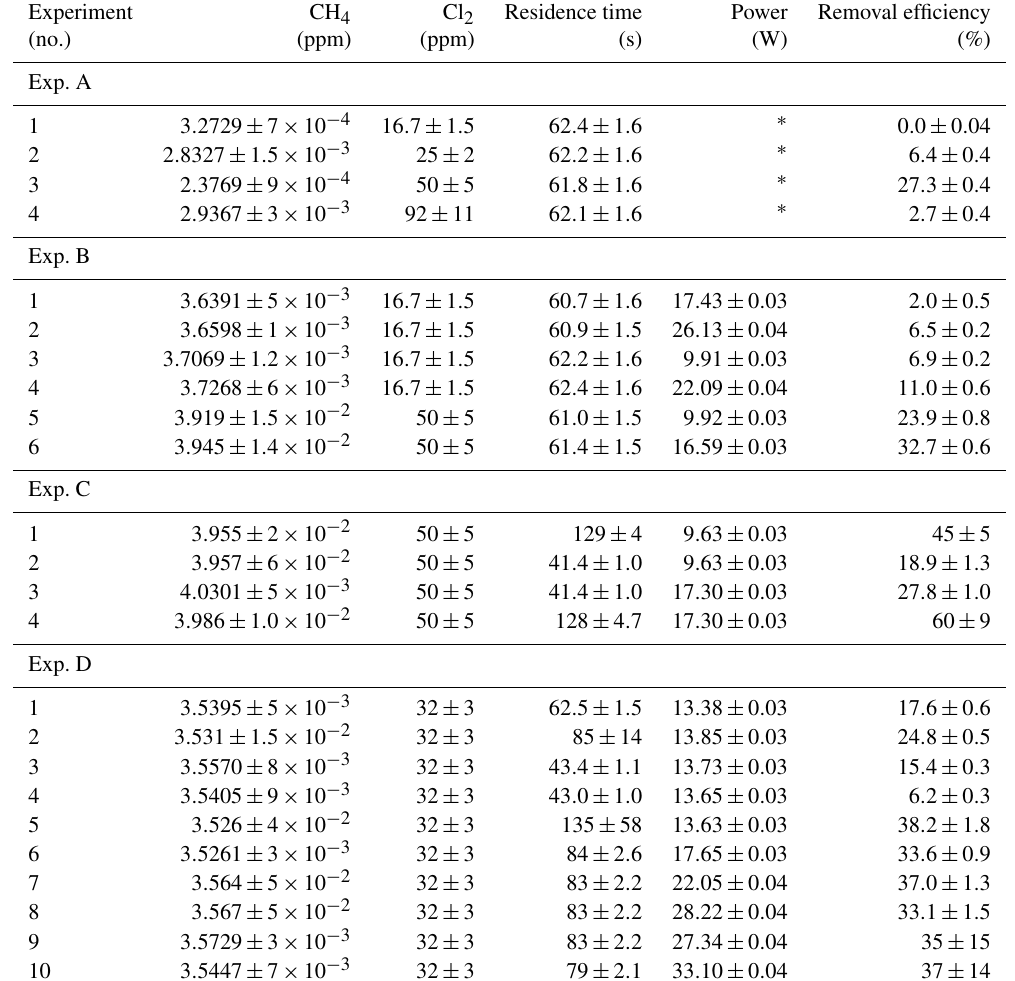
Table D1. Data for exp. A–D. Columns: experimental steps, [CH 4 ] (ppm), [Cl 2 ] (ppm), residence time t R (s), power input p IN (W) and the resulting removal efficiency in